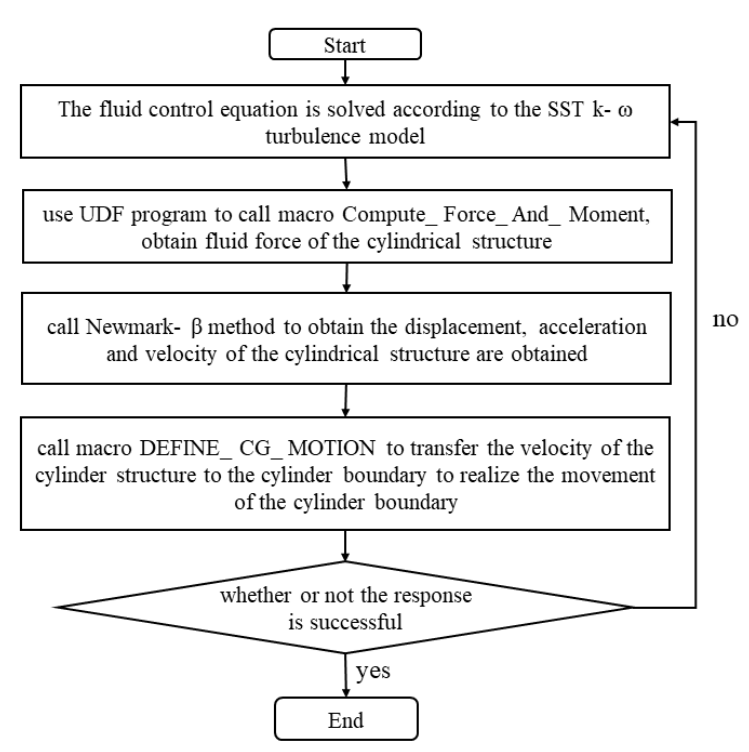
Figure 3. Program diagram for calculation.